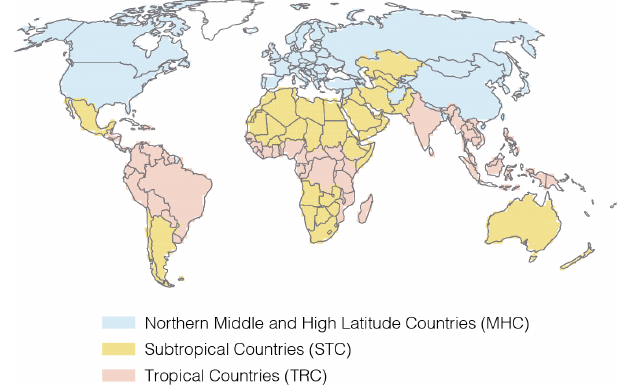
Figure 1. World map is divided into three climatic macro-regions: northern mid- and high-latitude countries (MHC), subtropical coun- tries (STC), and tropical countries